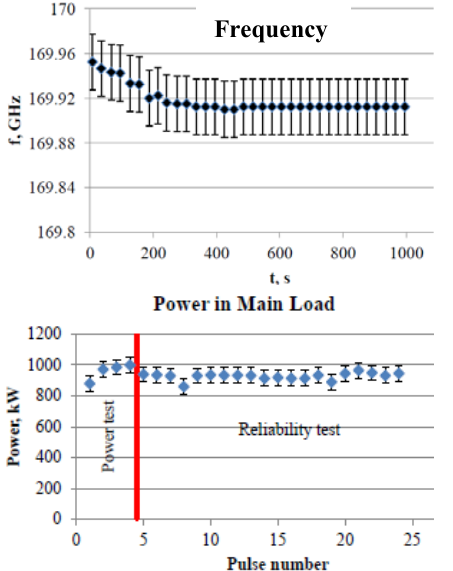
Fig.3 Statistics of frequency and power measurements for 500s and 1000s